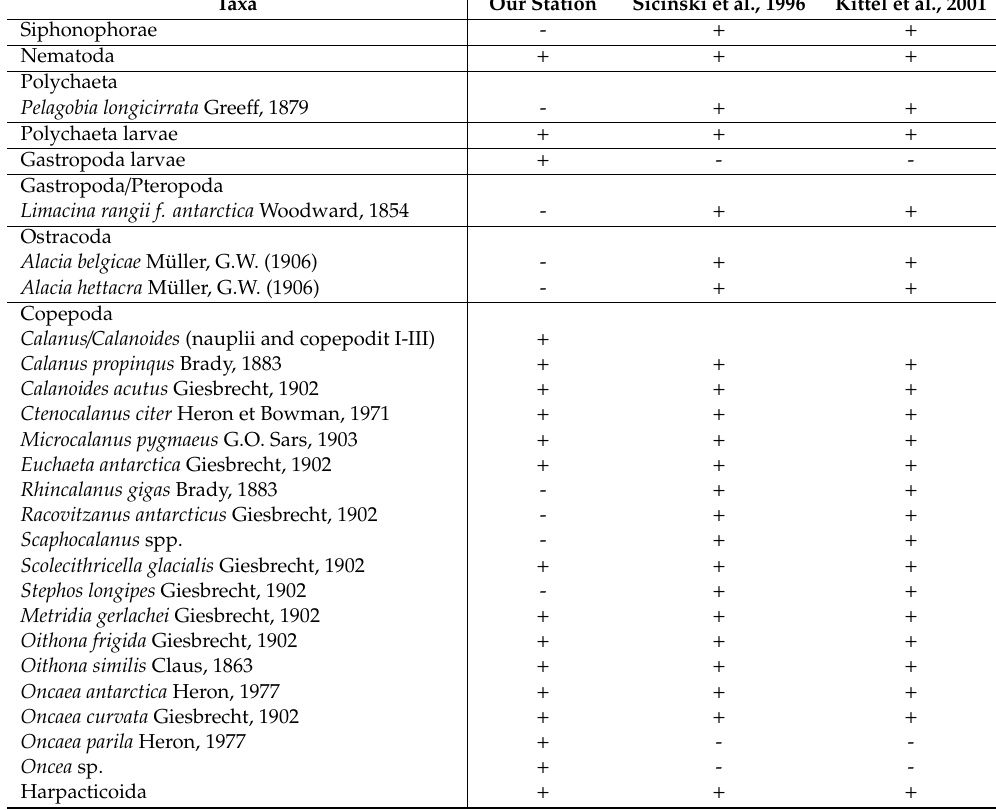
Table A1. Comparison of recorded planktonic taxa in Herve Cove in 2009 (three-month study) to those in 1993–1994 (year-round studies). Gray color—di ff erences between studies. Taxa Our